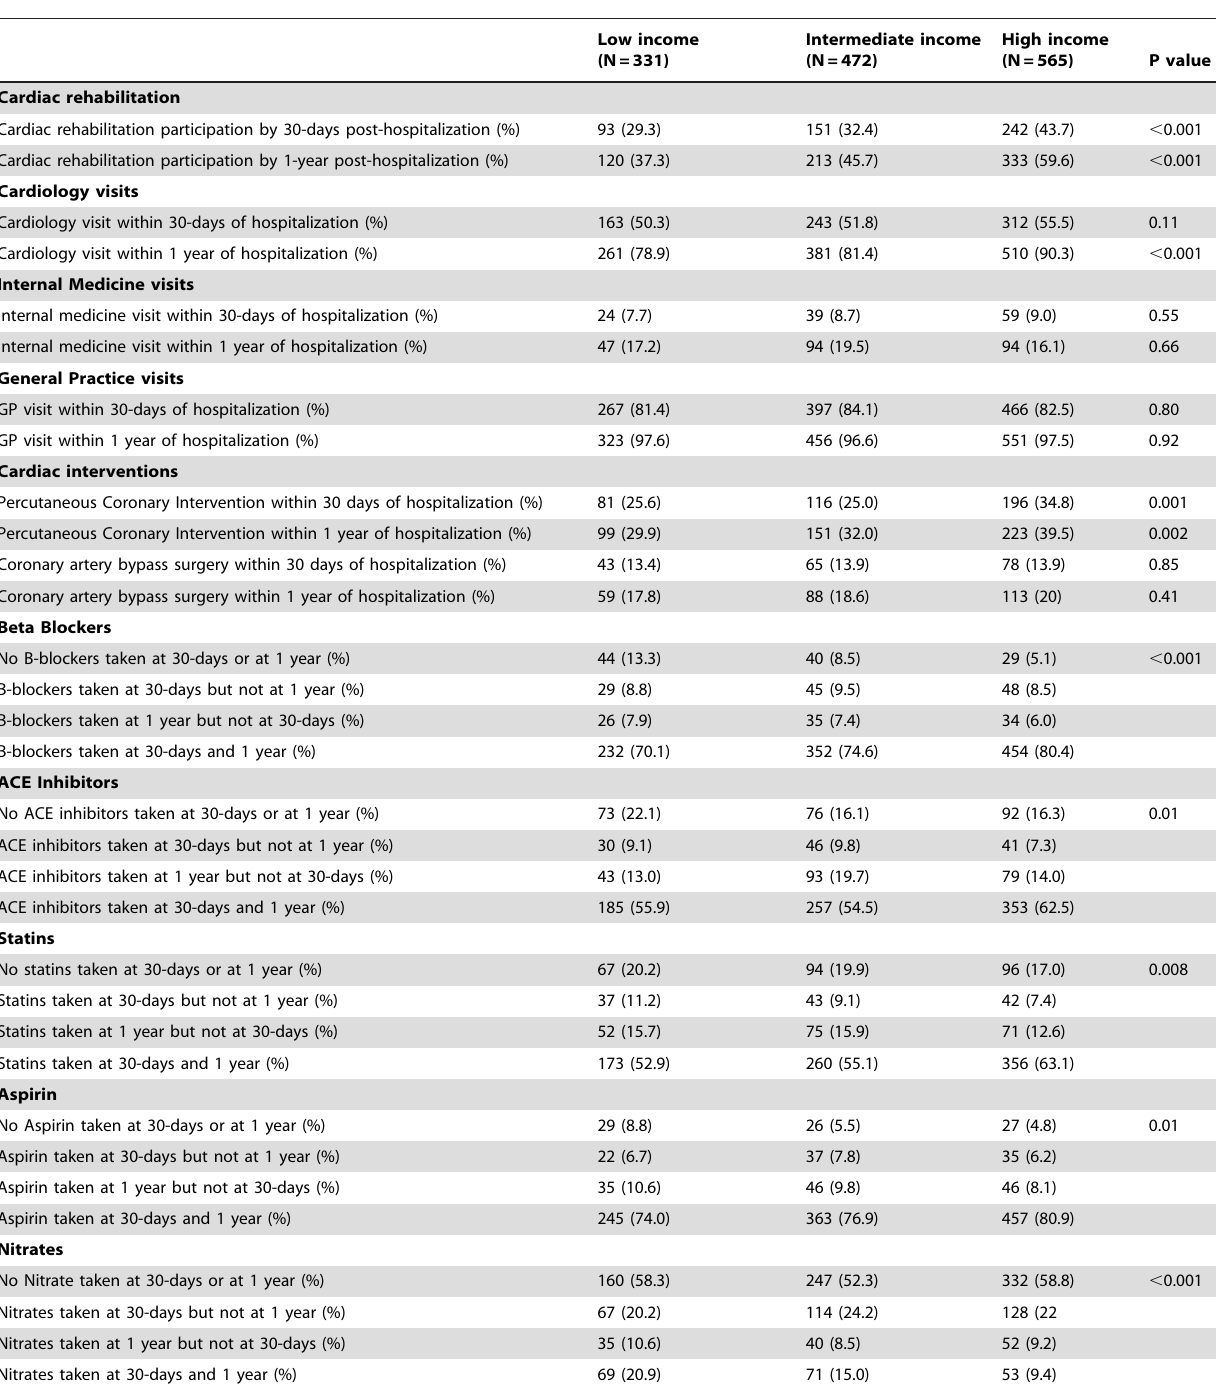
Table 3. Health service delivery according to income tertile during the year following AMI